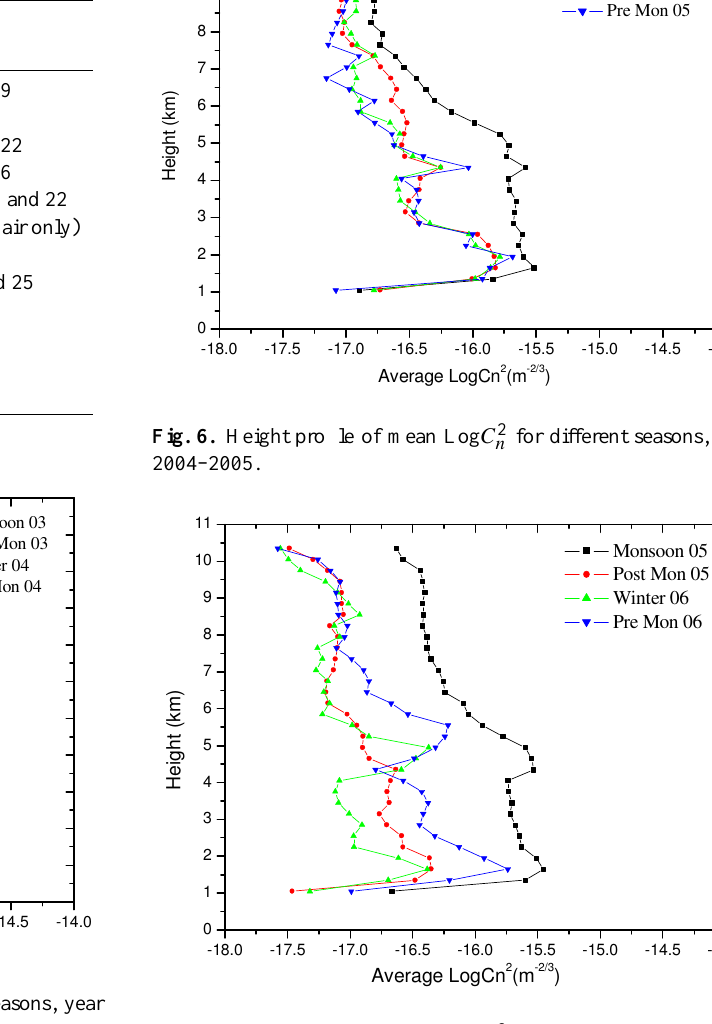
Fig. 7. Height profile of mean Log C 2 n for different seasons,